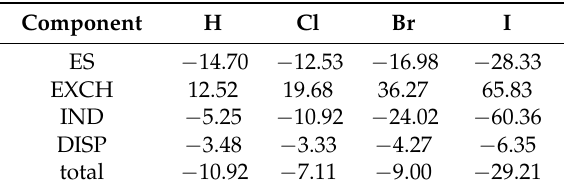
Table 10. SAPT energy components (kcal/mol) of ImZ + ··· NH 3